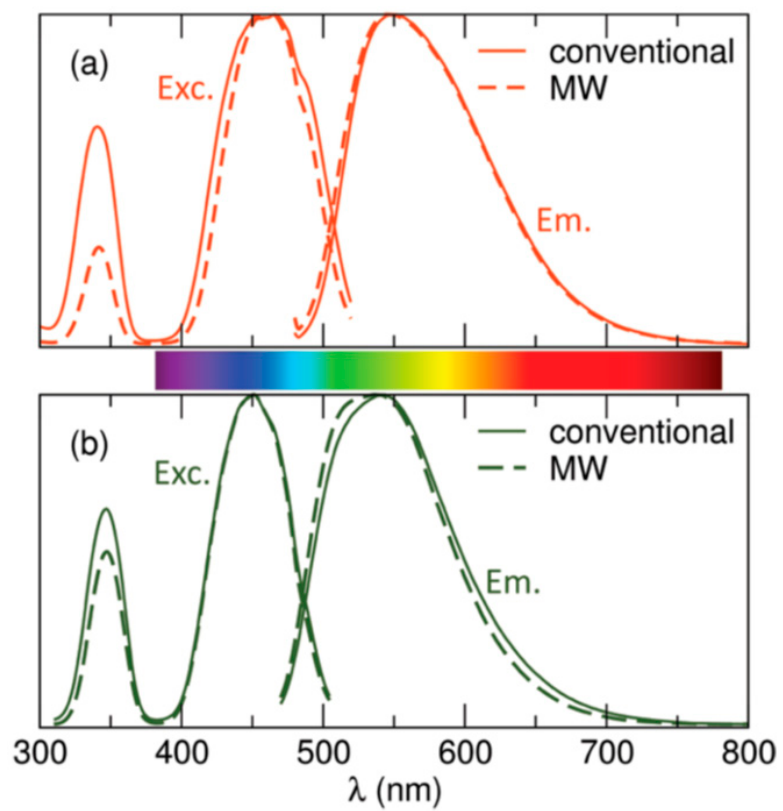
Figure 11. Excitation and emission spectra of Y 3 Al 5 O 12 :Ce 3+ ( a ) and Lu 3 Al 5 O 12 :Ce 3+ ( b ) obtained by both conventional (line) and MASS (dashed line) methods [83]. Copyright © 2012, American Chemical Society.